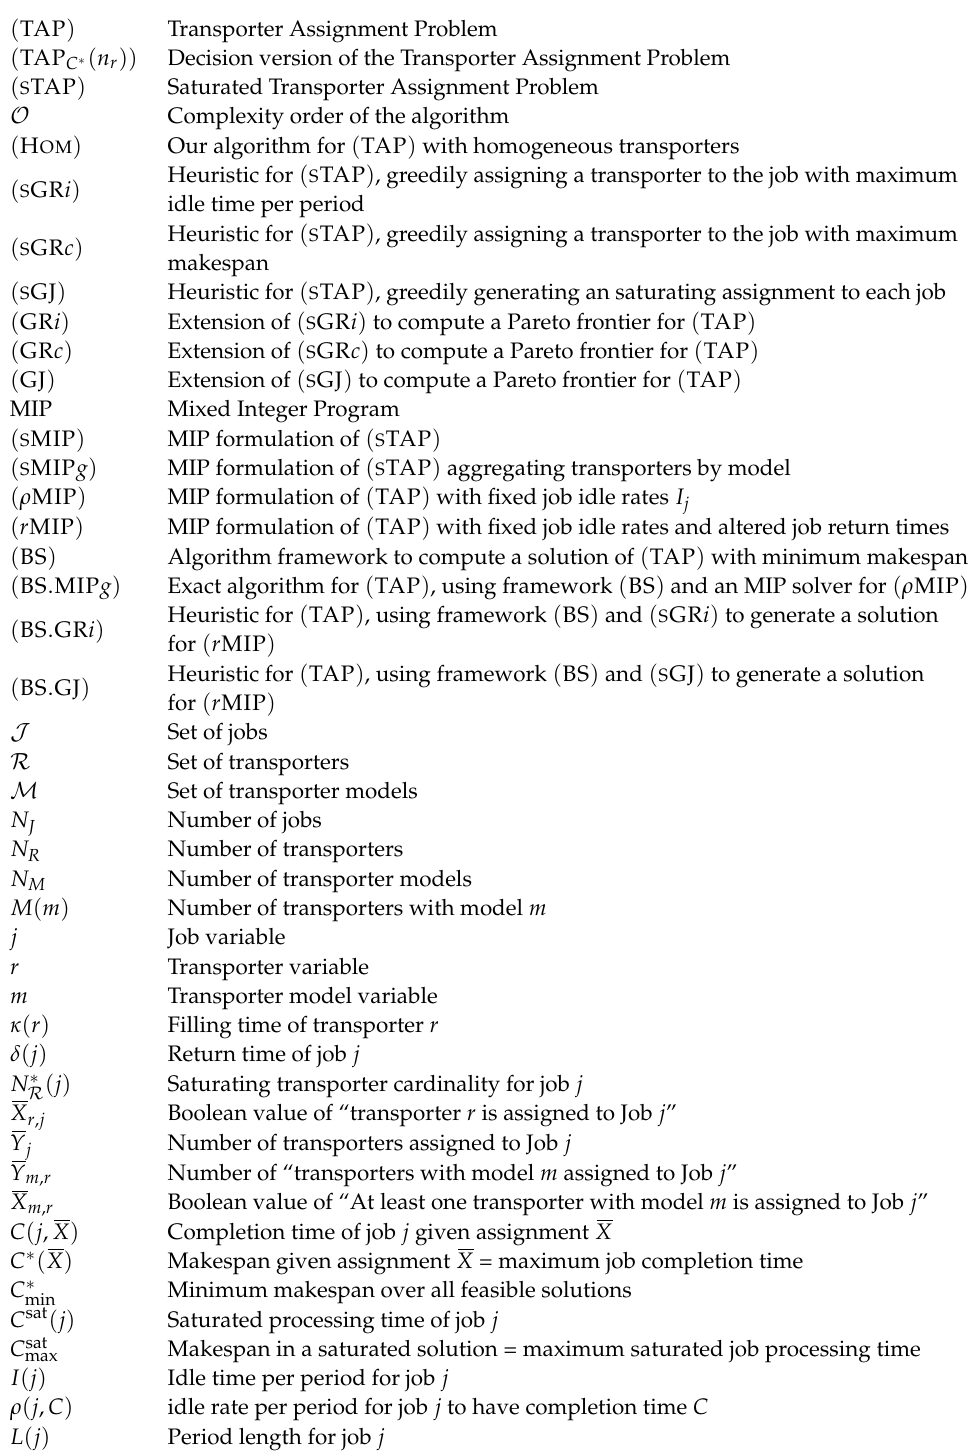
Algorithm framework to compute a solution of ( TAP ) with minimum makespan Exact algorithm for ( TAP ) , using framework ( BS ) and an MIP solver for ( ρ MIP